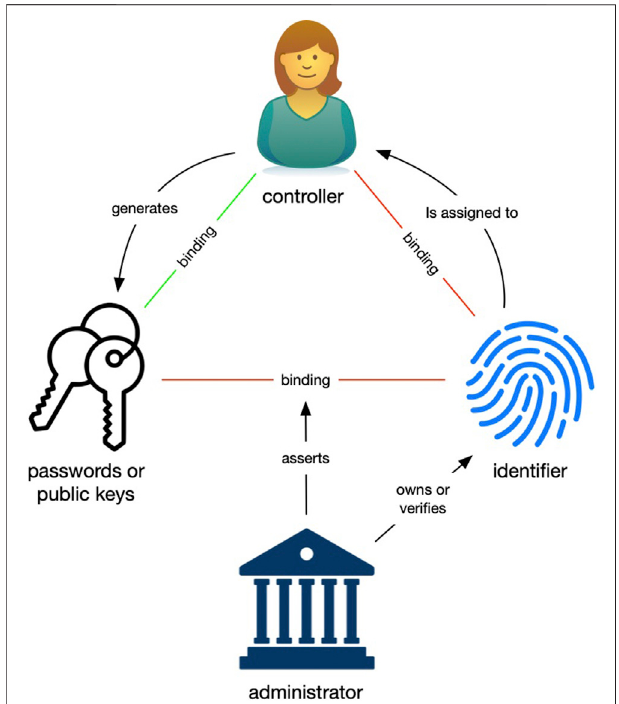
FIGURE 2 | The trust basis in administrative identity